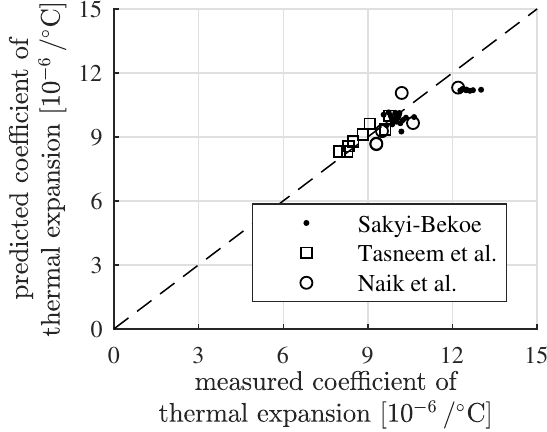
Figure 4. Comparison of model predicted thermal expansion coefficients of concrete with results from experimental measurements by Sakyi-Bekoe [2], Tasneem et al. [3] and Naik et al.